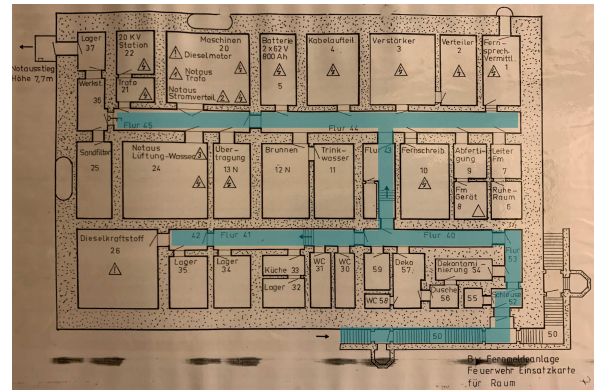
Figure 5. The floor plan of the bunker. The areas marked in blue are included in the dataset examined